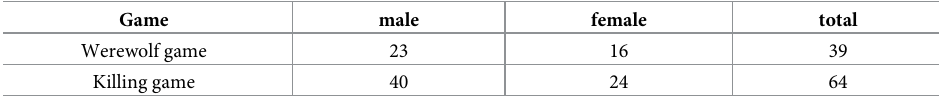
Table 1. Number of people participating in each game.